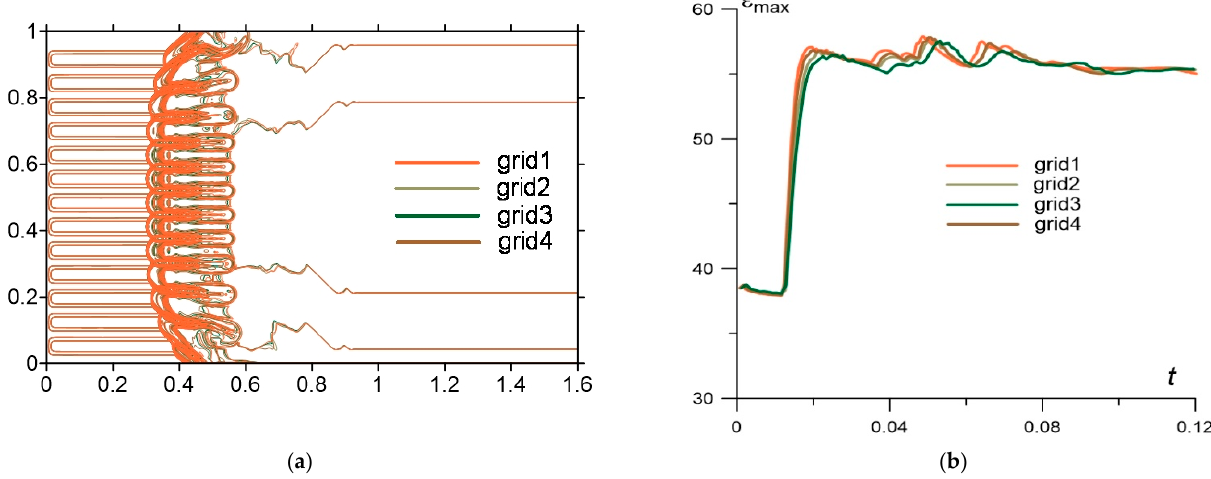
Figure 2. Comparison of the calculations on four different grids, M = 8, α = 0.4: ( a ) isolines of ε , t = 0.12 ( b ) dynamics of ε max .